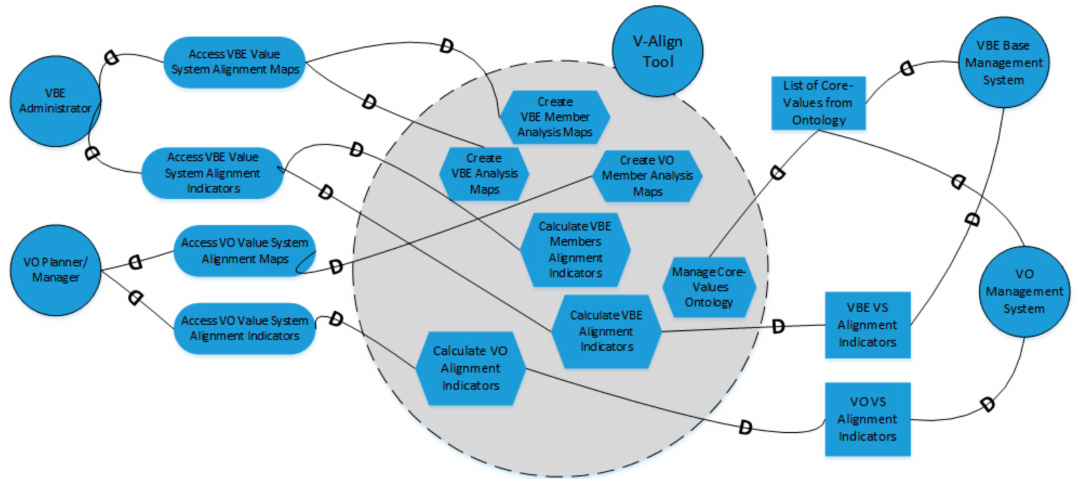
Figure 4. V-Align system: i* Rational Strategic model.